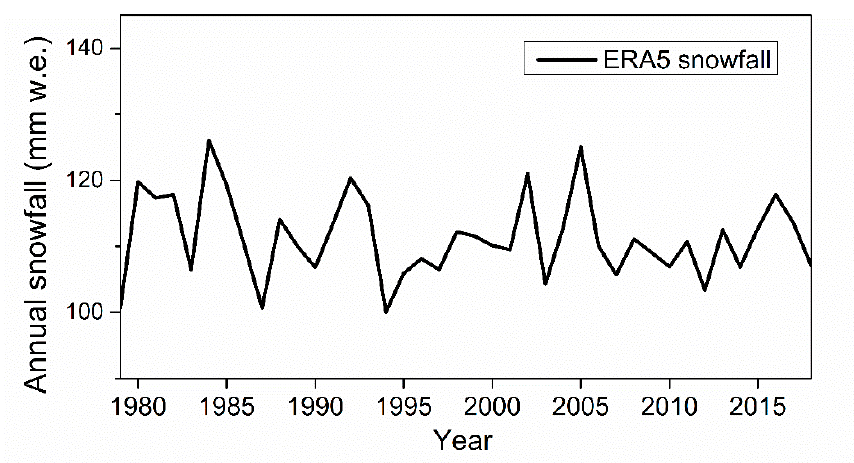
Figure 5. Annual snowfall (mm w. e.) over the AIS from 1979 to 2018.